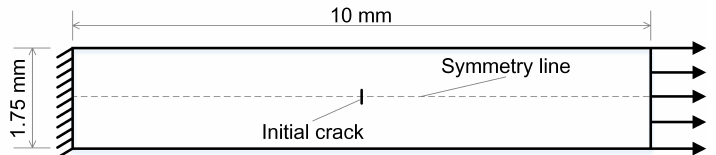
Figure 3. Configuration of a unidirectional specimen with a central cut.